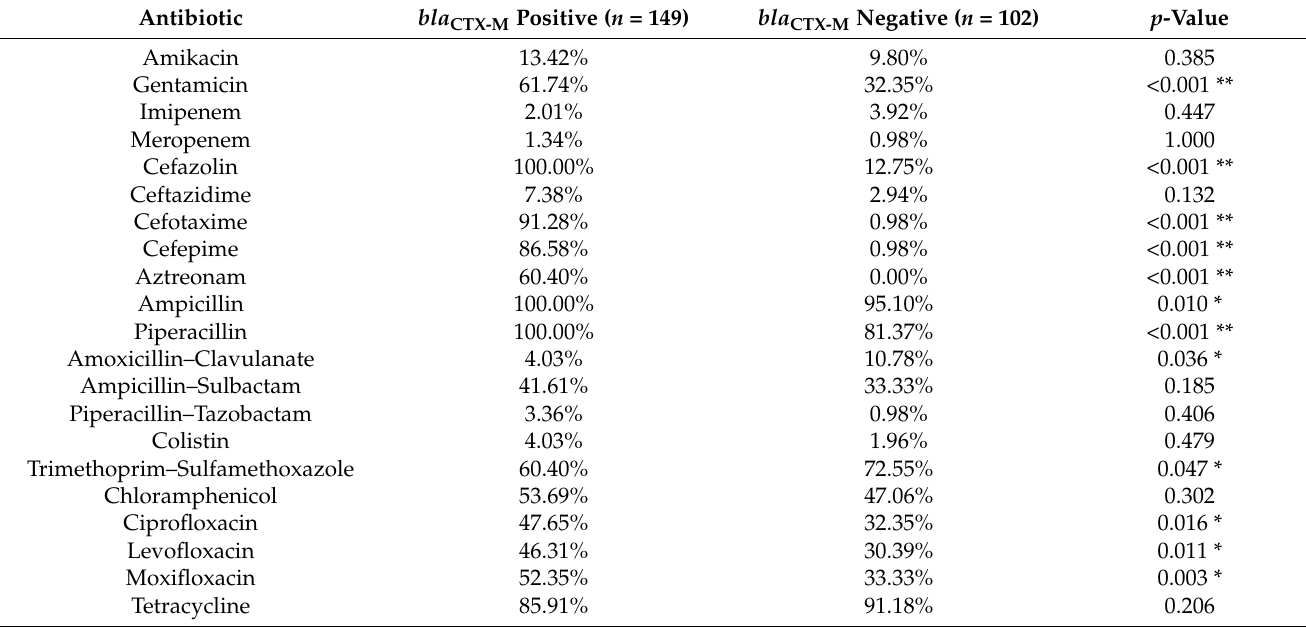
Table 2. Prevalence of the bla CTX-M gene and antibiotic resistance of MDR E. coli in 2021.